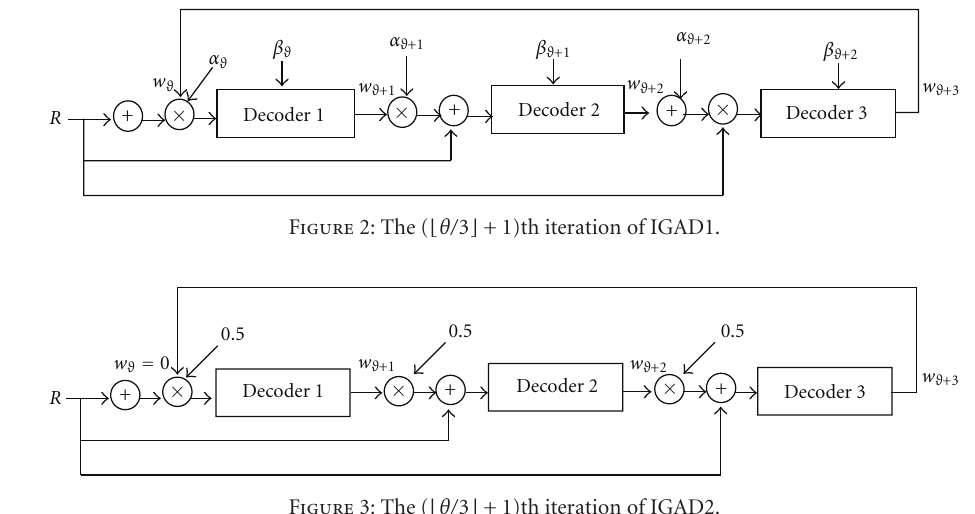
Figure 3: The ( (cid:12) θ/ 3 (cid:13) + 1)th iteration of